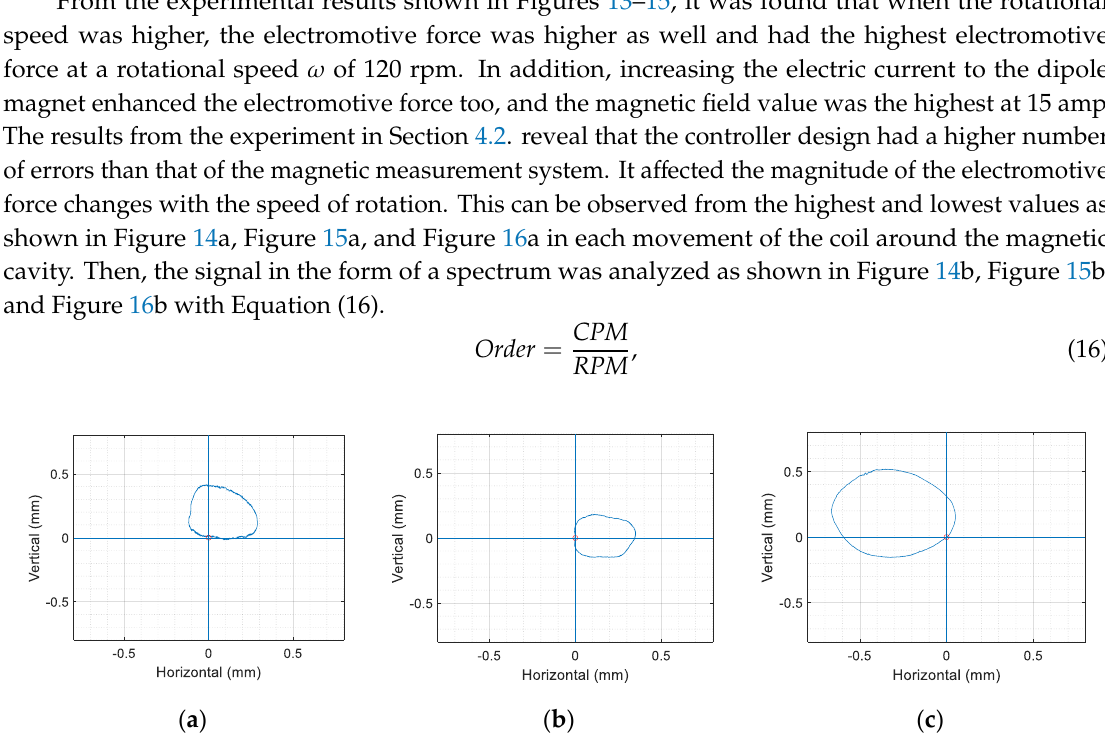
( c ) Figure 18. The comparison of the movement characters of the rotating coil at 120 RPM: ( a ) shaft orbit at the DE side; ( b ) shaft orbit at the center; ( c ) the shaft orbit at the NDE side. From the experiment shown in Figures 16–18 of each speed in rotation of the coil, they revealed that they all had similar orbital characteristics. That is because the shaft rotated at a low speed (low- speed machine); thus, the motion’s orbit changed little and maximum distance between maximum and minimum movement of the coil at different positions in the vertical and horizontal axis as shown in Table 5. The motion’s behavior moved away from the center of the rotation. At the DE position, the coil rose up; at the C position, it moved to the right; at the NDE position, it moved to the left. From the experimental orbital motion of the magnetic field measurement using the rotating coil technique, it was found that the movement of the cylinder rods was caused by rotational unbalance, and misalignment and mechanical looseness did not affect the measurement of the dipole magnetic